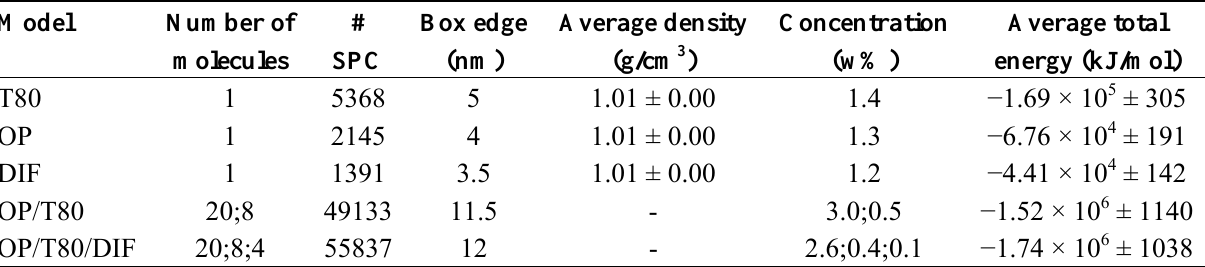
Table 3. An overview of the MD